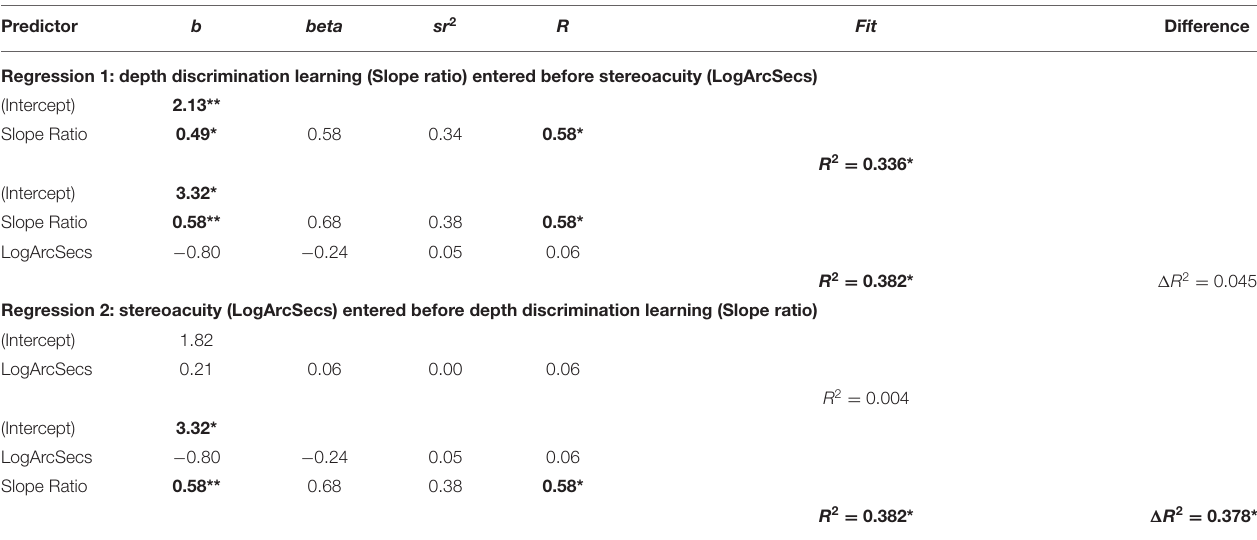
TABLE 3 | Results of a pair of hierarchical regression models predicting gains of performance efficiency during skill training. Predictor b beta sr 2 R Fit